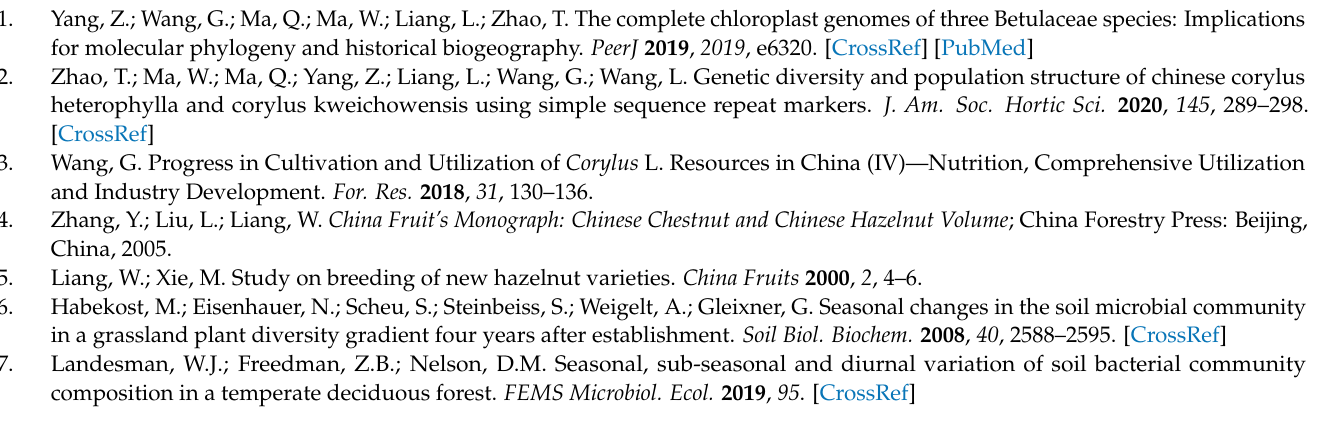
Heatmap of correlation analysis of fungal environmental factors. Figure S7: Heatmap of correlation analysis of bacterial environmental factors. Figure S8: Receiver operator characteristic (ROC) curves of Maxent model. Figure S9: Modelled climatically suitable areas for the C. kweichowensis at 2041–2060. Table S1: Soil Properties of four Corylus species. Table S2: Significant differences in soil properties and microbial diversity of four Corylus species. Table S3: Microbial diversity of four Corylus species. Table S4: Redundancy analysis (RDA) of fungi and bacteria with soil properties of four Corylus